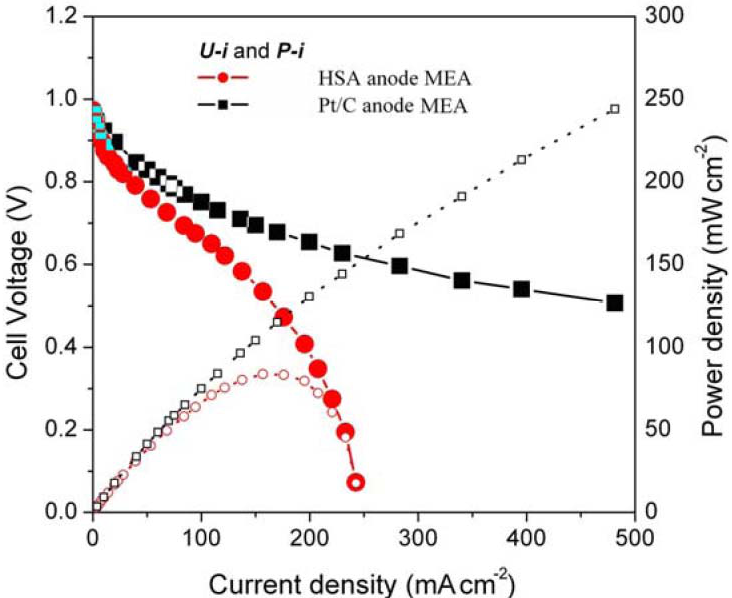
Figure 4. U-i and P-i characteristics for the HSA anode MEA and for the Pt/C anode MEA. Operating conditions: A = 1 cm 2 , Open symbols refer to the RH